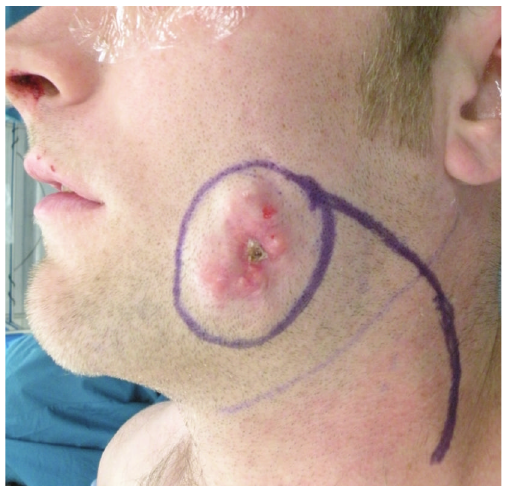
Figure 1: Clinical view of the lesion with calcified portion protrud- ing from the central part of the lesion.